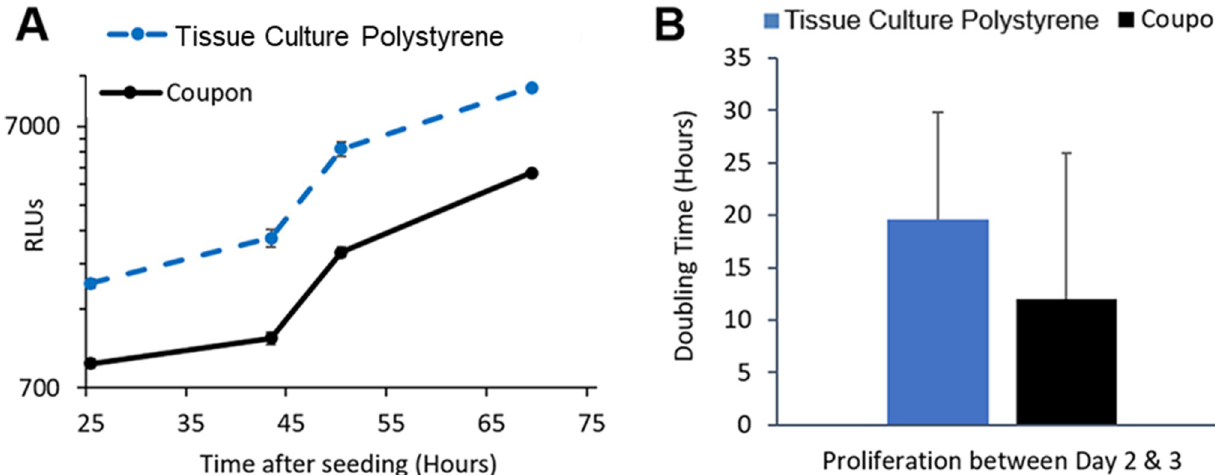
Fig 5. MSC proliferation on DLP printed coupons. (A) MSCs were seeded at an approximate density of 40% (1x10 4 cells/cm 2 ) onto tissue culture polystyrene (12-well plates) and coupons. Cells were cultured for 3 days in the presence of RealTime-Glo TM MT Cell Viability Assay (Promega). Relative luminescence unit (RLUs) was measured at various time points and plotted using a logarithmic y-axis. (B) Cell doubling times were comparable to cells attached on tissue culture polystyrene plates.